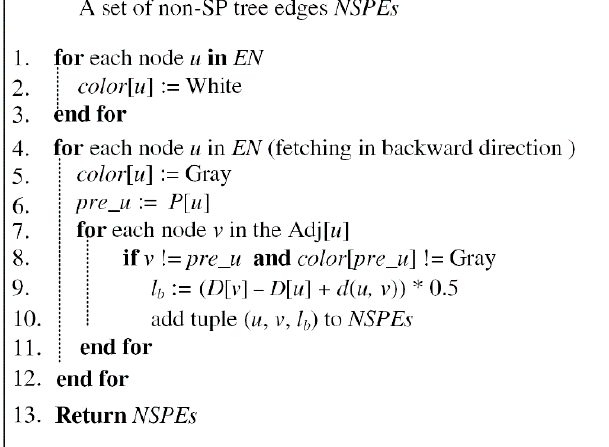
Figure 4. Algorithm of finding the non-SP tree edges of a facility.